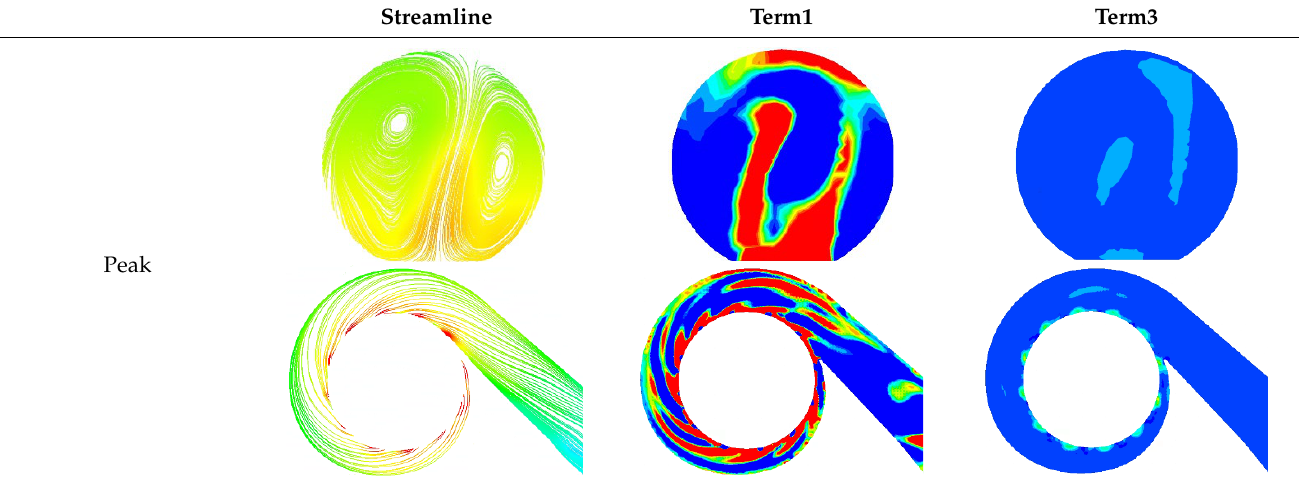
Table 4. The flow pattern and power loss distribution in volute under hump condition. Streamline Term1 Term3